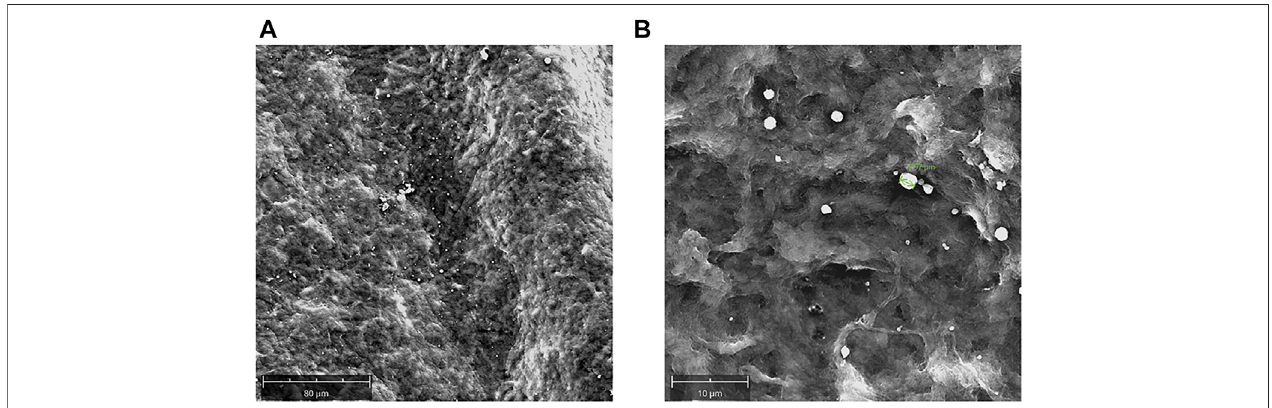
FIGURE 5 | Decellularized lenticules loaded with rhNGF-MPs. Representative SEM images of decellularized lenticules engineered with rhNGF-MPs. Lenticules were fi xed in glutaraldehyde (3.5%), dehydrated and sputter-coated with gold layers (150 (cid:1) A). Lenticules surface were captured at different magni fi cations (A,B) by using SEM Phenom XL (Alfatest) ( n = 3).